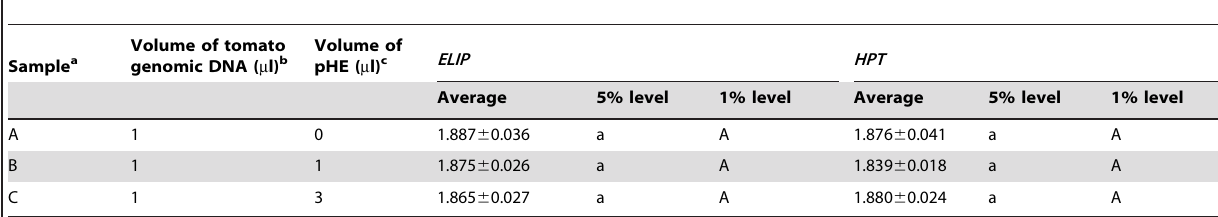
Table 2. Effects of pHE DNA addition on PCR efficiency.